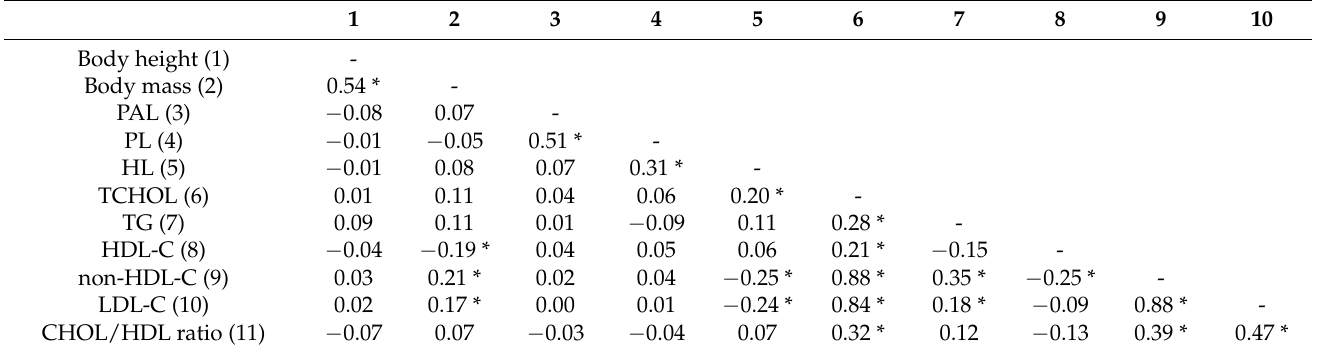
Table 5. Correlations between studied variables for girls ( n =